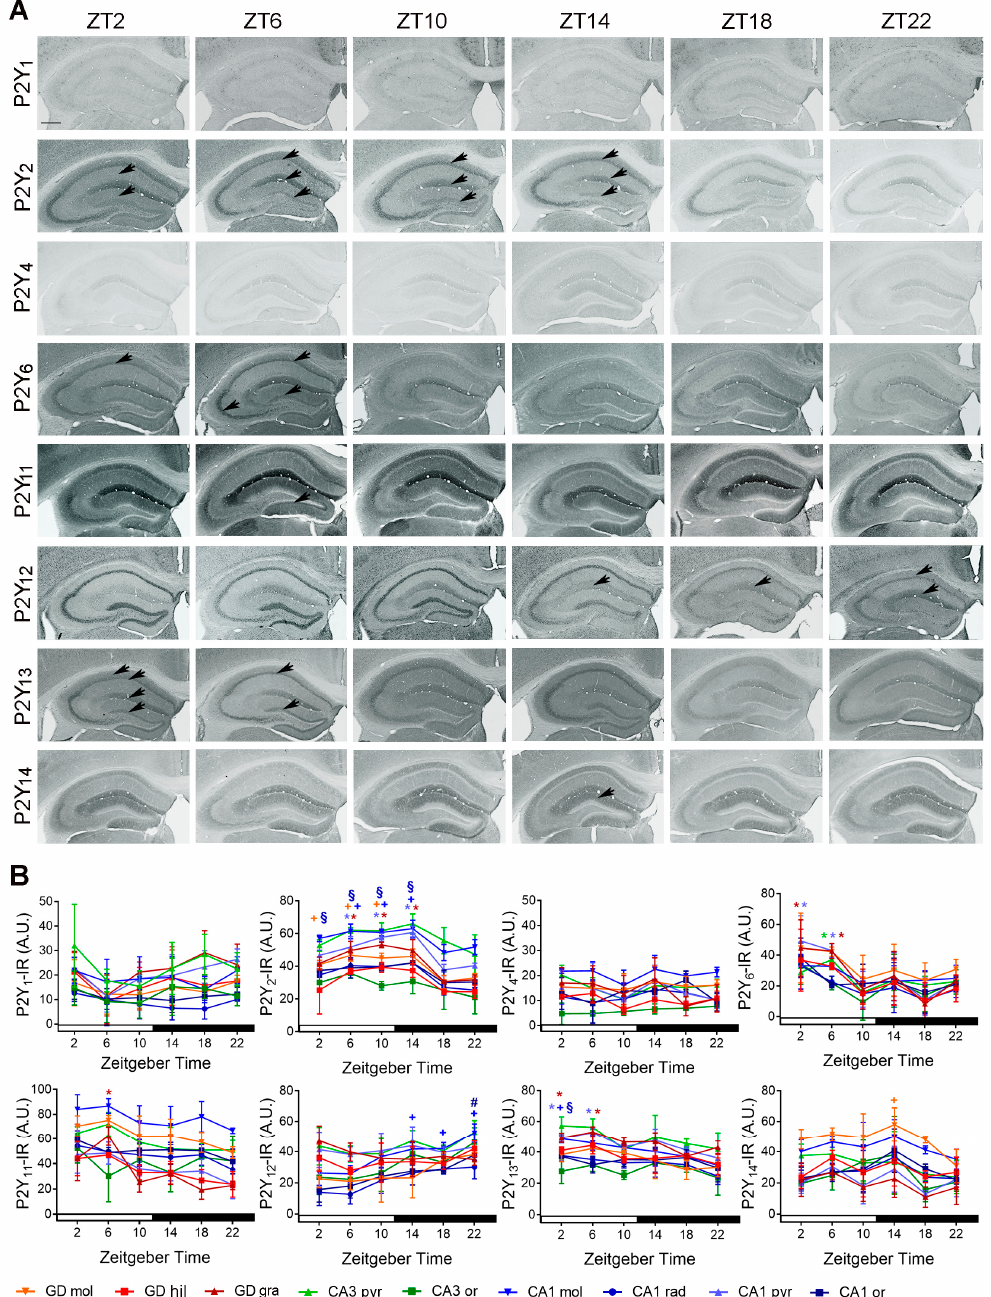
Figure 6. Temporal distribution of P2Y-IR in the mouse hippocampus. ( A ) Representative microphotographs of P2Y-IR in the hippocampus of mice killed at different zeitgeber times (ZT). Scale bar, 400 µm. ( B ) Quantitative analyses of P2Y-IR in the hippocampal layers. Red, green, blue * indicate significantly ( p < 0.05 vs. through time) elevated levels in granule (gra) and pyramidal (pyr) cell layers of dentate gyrus, CA3 and CA1, respectively. Red, green, blue + indicate significantly ( p < 0.05 vs. through time) elevated levels in molecular (mol) cell layers of dentate gyrus, CA3 and CA1, respectively. Red, green, blue # indicate significantly ( p < 0.05 vs. through time) elevated levels in hilus (hil) and stratum oriens (ori) of dentate gyrus, CA3 and CA1, respectively. Red, green, blue § indicate significantly ( p < 0.05 vs. through time) elevated levels in stratum radiatum (rad) of CA1. Shown are the mean+/ − arbitrary units (A.U.) of grey values above background of n = 3 mice per time point. Arrows indicate subregions of significantly high expression.